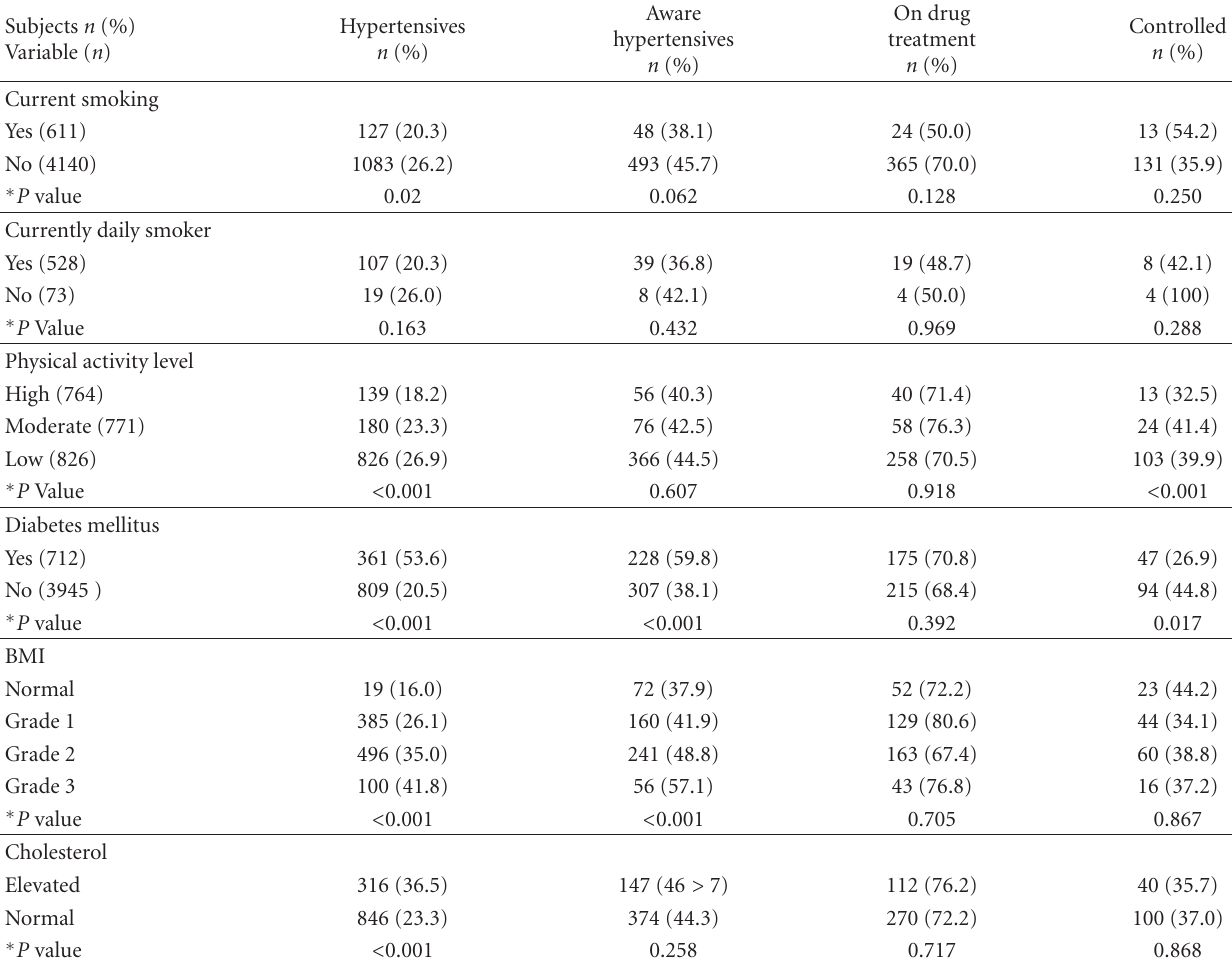
Table 2: Hypertension prevalence, awareness, treatment, and control according to some life style characteristics, diabetes, and cholesterol level ∗